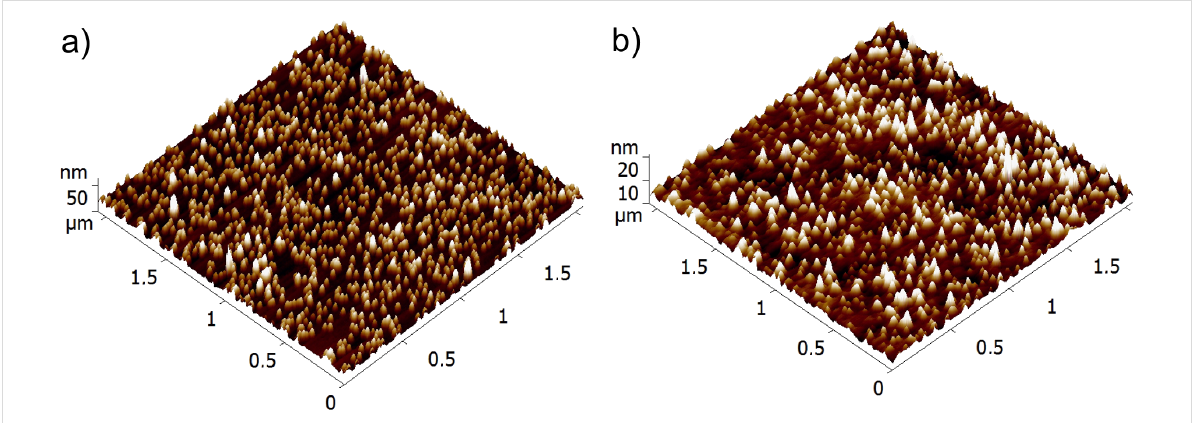
Figure 1: AFM images of (a) Cu clusters as-deposited on PS and (b) clusters after thermal annealing causing partial embedding of NPs.